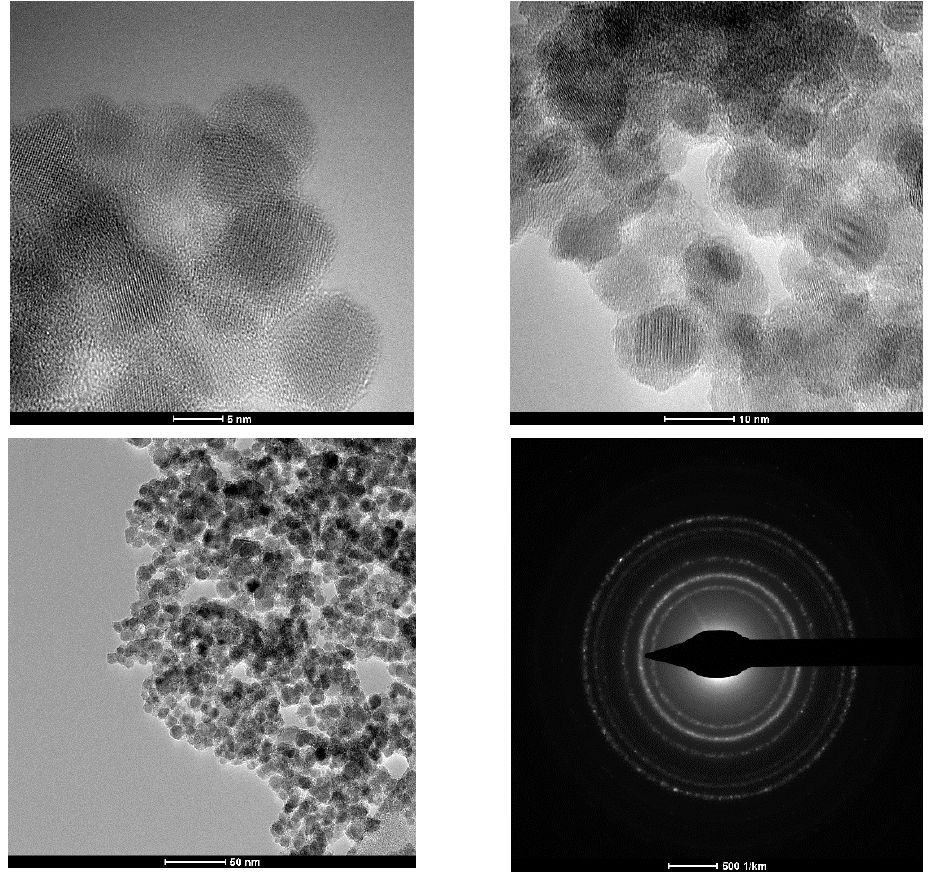
Figure 5. TEM and SAED images for MW-NPS-1 nanoparticles. The morphology of the MW-NPS-2 nanoparticles was determined by TEM (Figure 6). The obtained images confirm the presence of the silica shell with a thickness of ap- proximately 2 nm. The crystal structure of Fe 3 O 4 is confirmed by the SAED image.